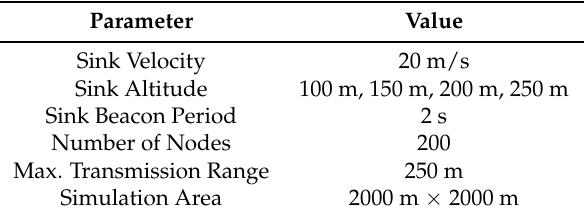
Table 1. Simulation